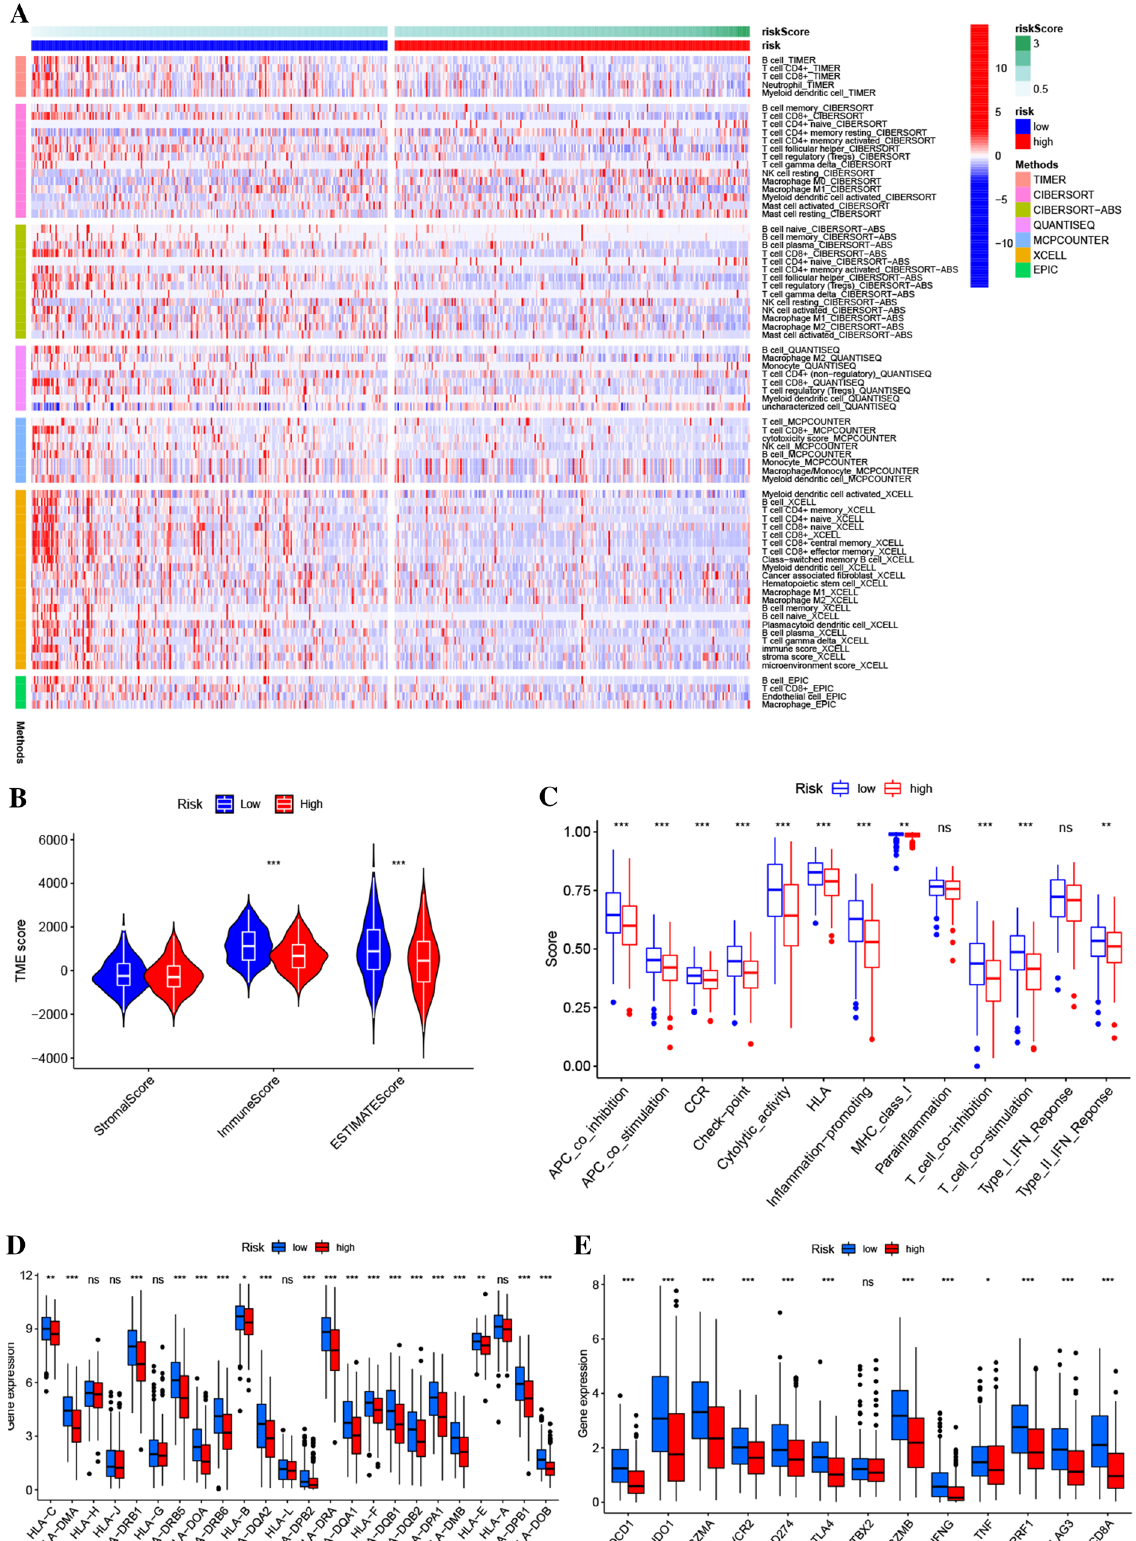
Figure 7. Association between the tumor immune landscape and rrlncRNA signature. ( A ) Heatmap depicting tumor-infiltrating immune cells based on EPIC, CIBERSORT-ABS, XCELL, MCPCOUNTER, QUANTISEQ, CIBERSORT, and TIMER algorithms between low- and high-risk cohorts in HNSCC. ( B ) ESTIMATE analysis between low and high-risk cohorts. ( C ) Immune-related function analyses between low and high-risk cohorts. ( D ) The expression of the HLA gene family between low and high-risk cohorts. ( E ) The expression of immune checkpoints genes between low and high-risk